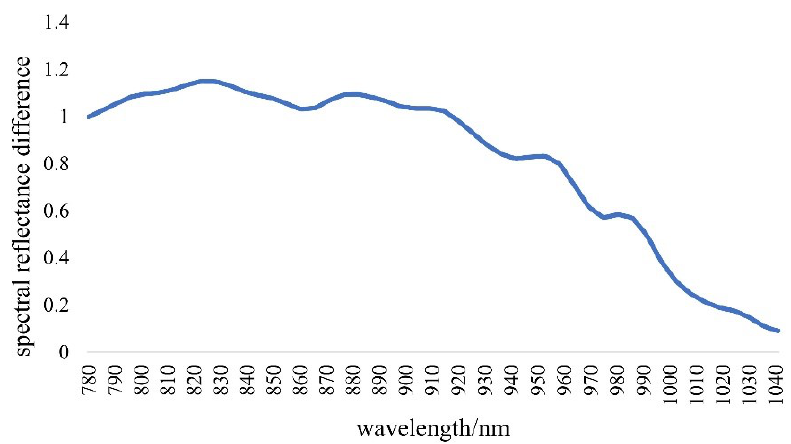
Figure 8. Curve of spectral reflectance difference between cabbage and Pieris rapae .